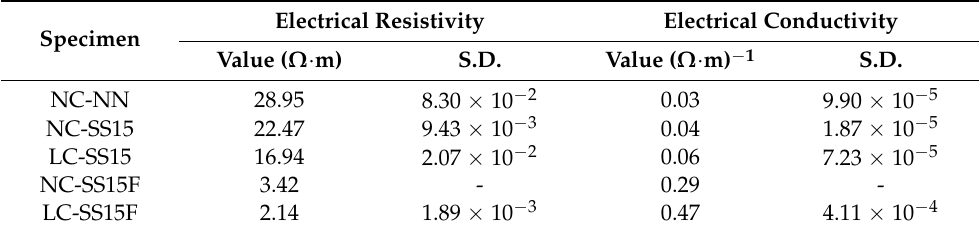
Table 5. Electrical resistivity and electrical conductivity of concrete at 28